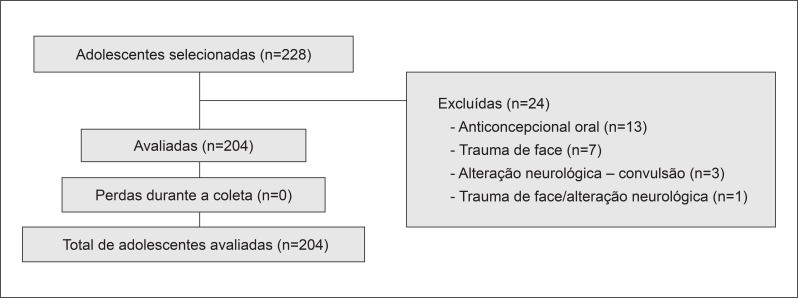
Diagrama de elegibilidade das adolescentes